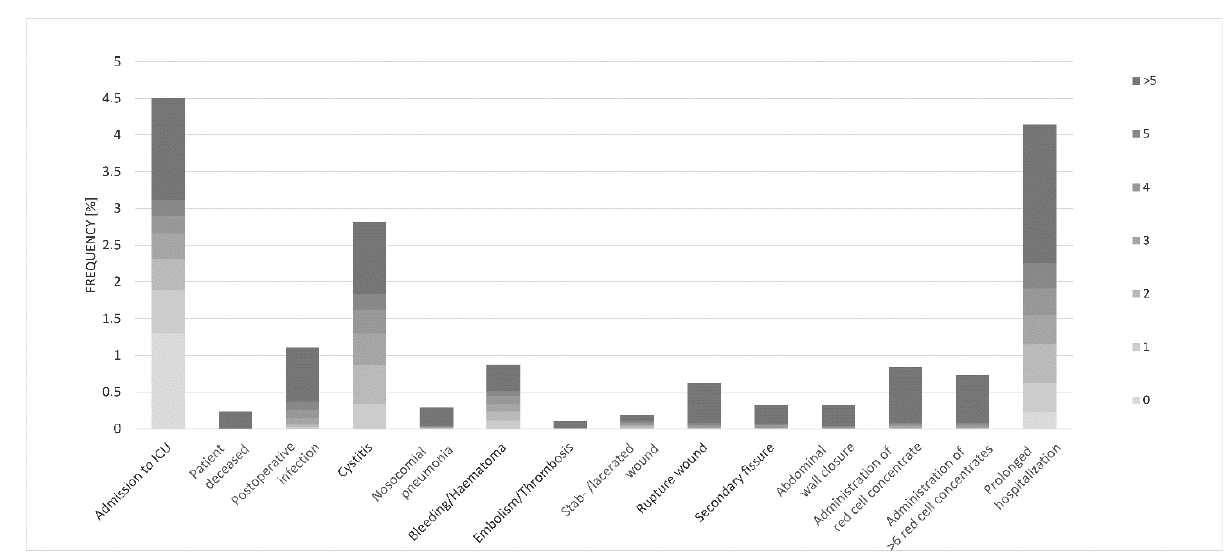
Figure 8. Type and frequency of complications. Recorded complications regarding the number of side diagnoses with main diagnosis acute appendicitis of all appendectomy cases (adults) in CLINOTEL Association between 2010 and 2017, n = 3374.